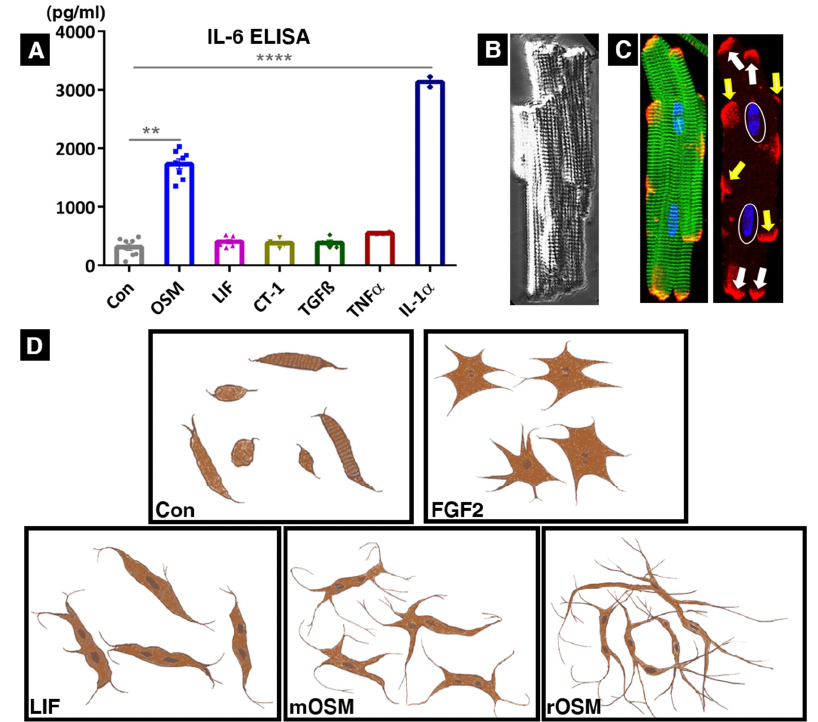
Figure 2. Schematic representation of morphological effects of activated type I and type II receptor complexes on cultured adult rat cardiomyocytes and IL-6 secretion. In all our screens, we utilized 20 ng/mL of albumin (Con), rat leukemia inhibitory factor (LIF, activates the rat LIFR/gp130 com- plex), mouse oncostatin M (mOSM, activates the rat OSMR/gp130 receptor complex), rat oncostatin M (rOSM, activates the rat LIFR/gp130 and the rat OSMR/gp130 complex), cardiotrophin-1 (CT1), transforming growth factor- β (TGF β ), tumor necrosis factor- α (TNF α ), interleukin-1 α (IL-1 α ), and fibroblast growth factor-2 (FGF2). ( A ) IL-6 ELISA showing concentrations of IL-6 in the cardiomyo- cyte culture supernatants 36 h after stimulation with albumin ( n = 8), OSM ( n = 8), LIF ( n = 6), CT-1 ( n = 6), TGFß ( n = 4), TNF α ( n = 4), and IL-1 α ( n = 2). Data represent the mean ± SEM. Statistical analysis was performed through an unpaired t test with Welch’s correction showing significances between Con and OSM **** p < 0.0001 and between Con and IL-1 α ** p < 0.002. ( B ) Bright-field mi- crograph of a freshly isolated rat cardiomyocyte showing a complex three-dimensional structure with typical cross-striation. ( C ) Intercalated discs (stained with connexin-43 in red) are organized laterally (yellow arrows) and at the cell ends (white arrows). White ovals indicate nuclei and the green color marks sarcomeres (stained with sarcomeric α -actinin) in a freshly isolated cardiomyo- cyte. ( D ) Scheme summarizing the main morphological effects of rOSM, mOSM, LIF, and FGF2 after 5–7 days in culture. Cellular elongation and formation of multiple extensions were the most obvious changes after oncostatin M treatment. While elongation after rOSM stimulation was dominant, a certain amount of spreading might have become visible with increased culture time when cellular contacts were reestablished. It is important to note that serum (fetal calf serum, FCS) was only uti- lized for the initial plating of cardiomyocytes and then the cultures were kept without serum or any further growth enhancer/stimulant in these studies. For comparison, FGF-2-stimulated cultures show an increase in surface area but comparatively little elongation or formation of extensions.